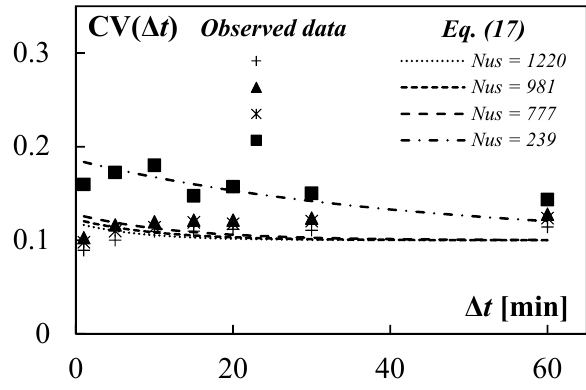
Figure 8. Effects of the time aggregation on the CV.